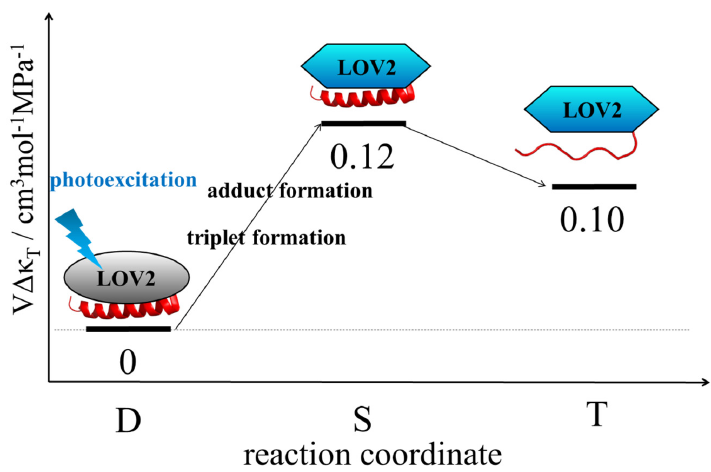
Figure 4. Compressibility change in phot1LOV2-linker during photoreaction.